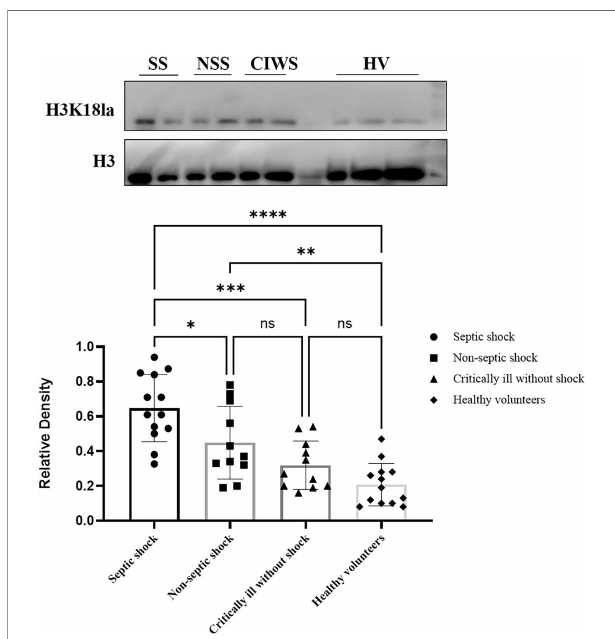
FIGURE 2 | Expression of H3K18 lactylation in ICU patients and healthy volunteers. H3K18la was expressed in all subjects, including the volunteers. The mean level of the H3K18la were signi fi cantly different among the four groups of septic shock, non-septic shock, critically ill without shock; and healthy volunteers (Welch ANOVA F=16.158, P <0.001). The differences were also signi fi cant between the septic shock group and the non-septic group, critically ill without shock group and healthy volunteers (Tukey post hoc test P= 0.033, 0.000 and 0.000, respectively). There is no signi fi cant difference between the critically ill without shock group and the healthy volunteers (Tukey post hoc test P= 0.390), or between the non-septic shock group and the critically ill without shock group (Tukey post hoc test P= 0.265). Compared with healthy volunteers, patients in the non-septic shock group have higher H3K18la (Tukey post hoc test P= 0.005). SS, septic shock; NSS, non-septic shock; CIWS, critically ill without shock; HV, healthy volunteers. *P < 0.05,